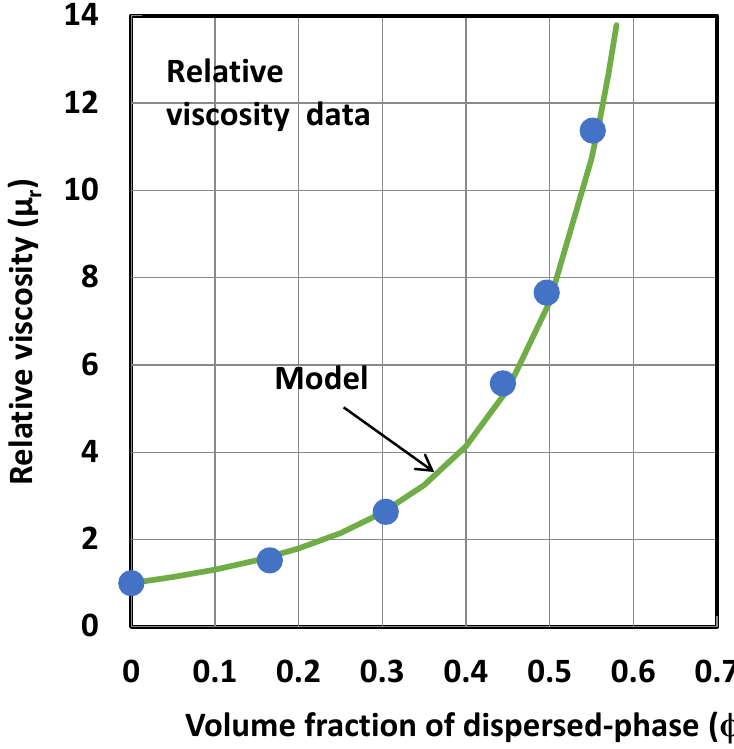
Figure 6. Variation of emulsion relative viscosity with volume fraction of dispersed phase.